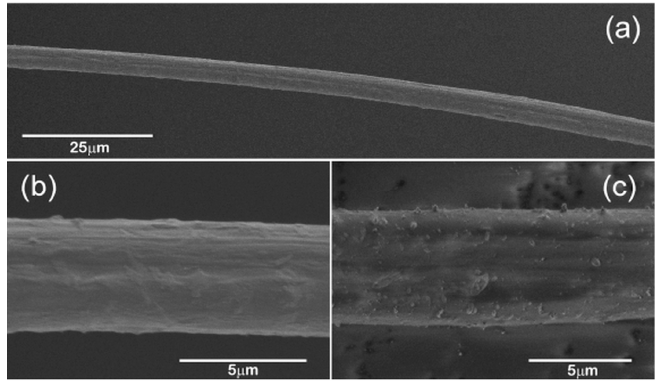
Figure 1. Secondary electron images obtained from ( a , b ) section of a B. terrestris silk fibre hand drawn at 0.14 cm/s and ( c ) a fibre hand drawn at 0.10 cm/s.